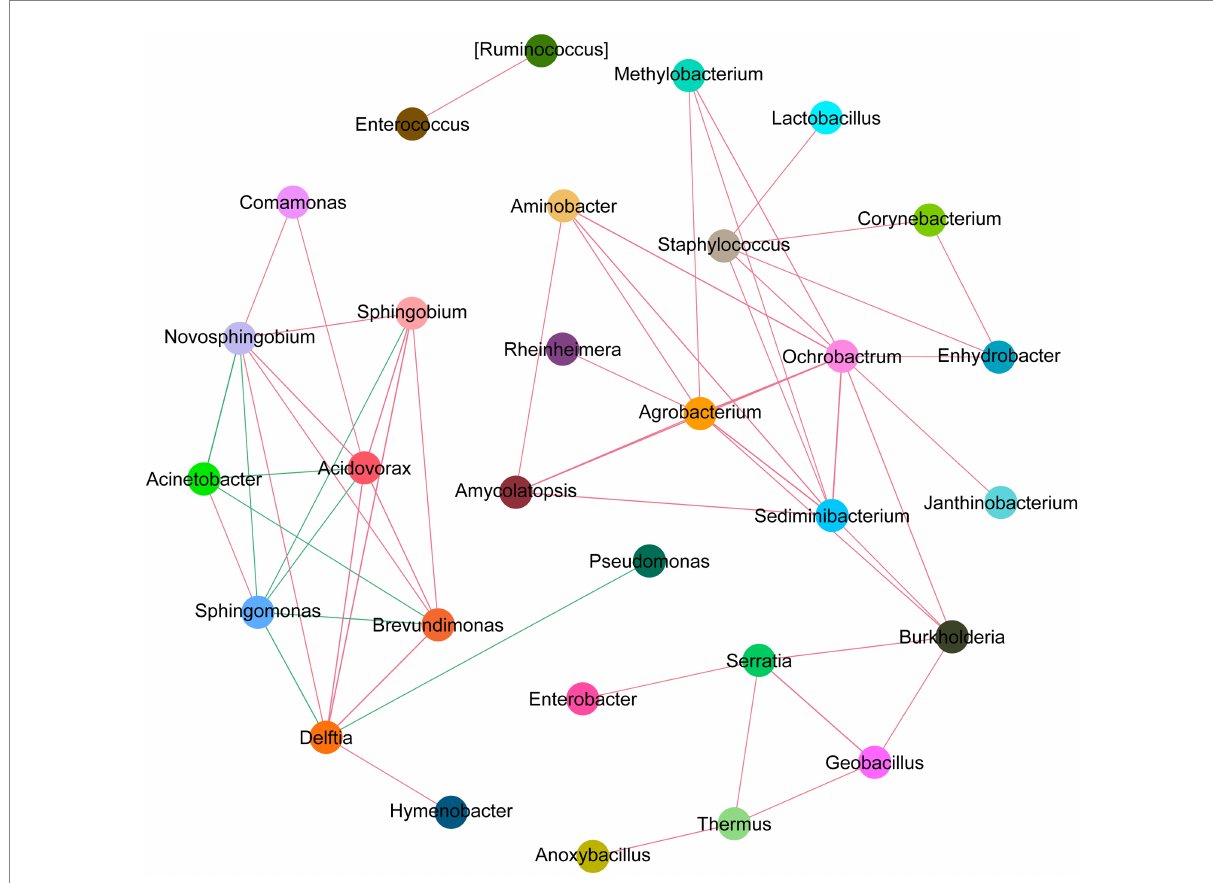
FIGURE 8 Network analysis diagram of species interaction in CRC with different MMR status. The circles in different colors indicate the dominant bacteria genera, and the lines between the circles indicate that the correlation between the two bacteria genera is significant ( p < 0.05). The red line represents positive correlation, and the green line represents negative